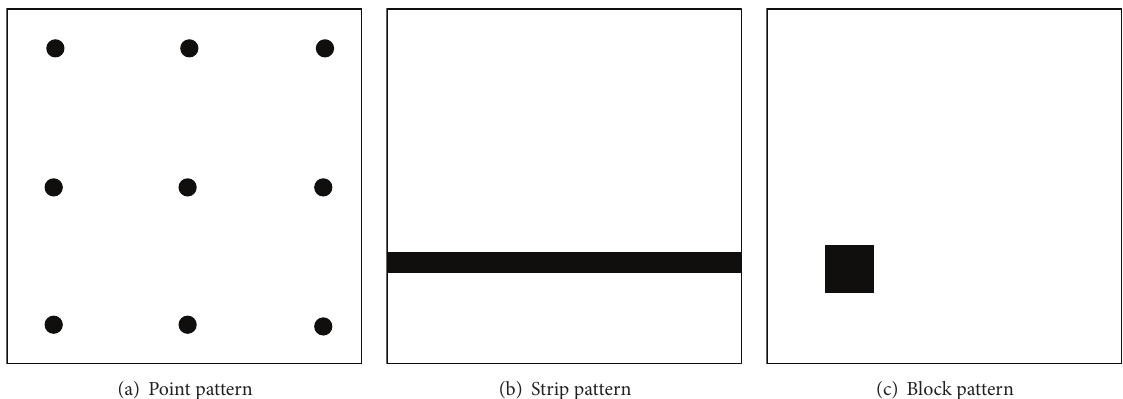
Figure 1: Three types of failure patterns with two-dimensional input domain.